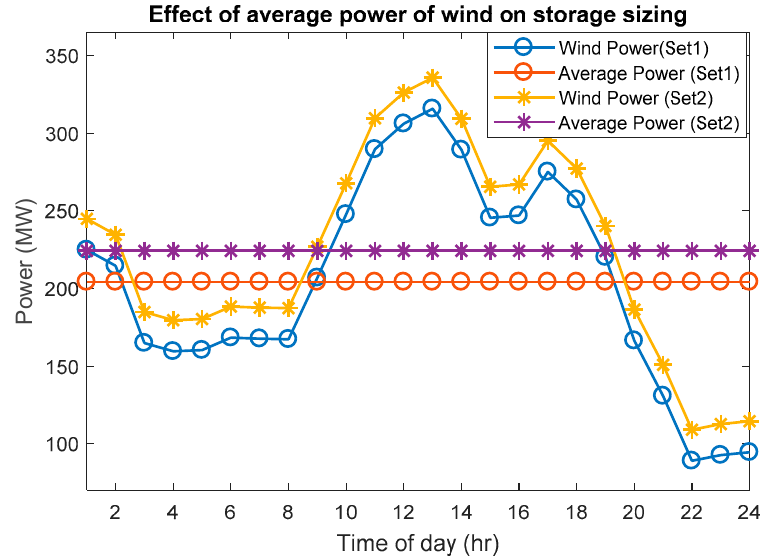
Figure 2. A sample wind data with a different average value but with the same daily variation. In the set of the plot, the wind data and its average value (204.3 MW) as represented by the “O” marker have a lower value compared to the second set of the plots represented by the “*” marker. The corresponding value for the average power of the second set is 224.3 MW, whereas the daily variation pattern is the same for the two sets. The storage sizing for both cases results in a lower size for the second case than the first case. A cost comparison was done, the result of which was that the second case is less costly than the first case for the same storage size.